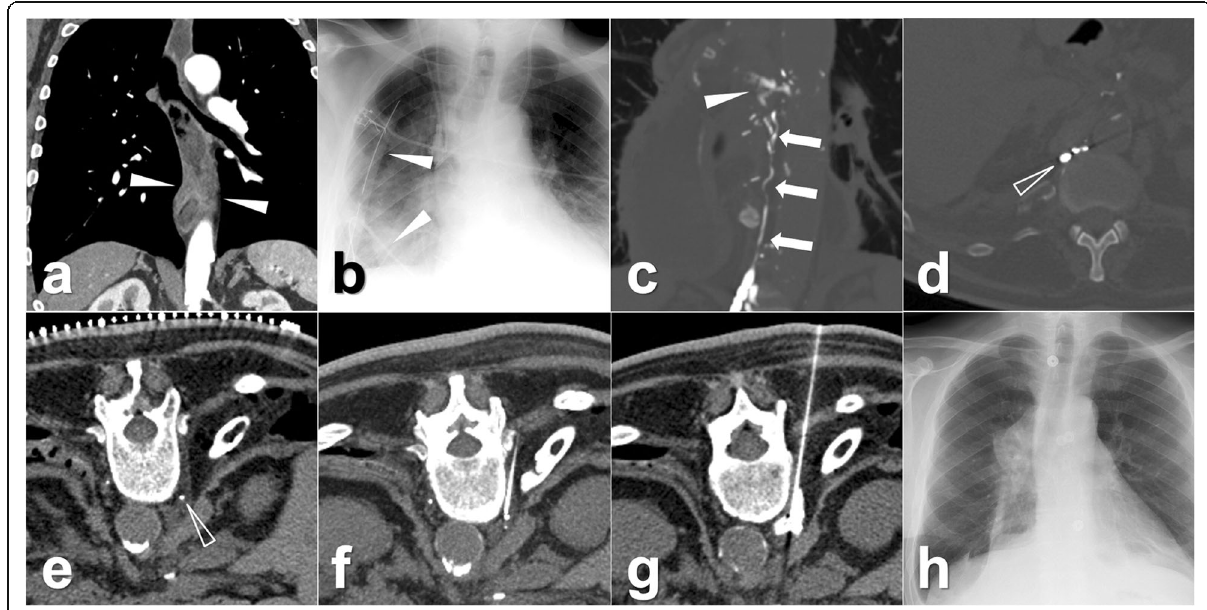
Fig. 2 Images from a patient who was diagnosed with erosive esophagitis-induced esophageal stenosis. a Contrast-enhanced CT showed an irregular thickness of the distal esophageal wall (white arrowheads). Then the thoracic-abdominal esophagus resection plus lymphadenectomy was performed. After the surgery, the right chylothorax appeared with the average daily output of 1,130 mL. b The two drainage catheters (white arrowheads) were also observed at the ideal locations in the chest radiogram. Due to the ineffective total parenteral nutrition with a high percentage of MCTs, TL was performed, and 15.0 mL of iodinated oil was injected. c Eight hours later, CT scan showed a definite rupture (white arrowhead) of the thoracic duct (white arrows) with the extravasation to the right pleural cavity. d The distal cisterna chyli (white